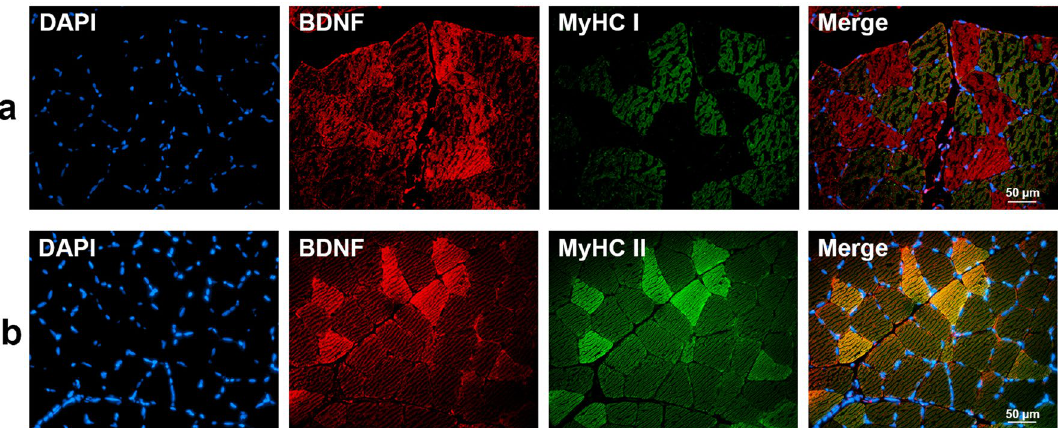
Figure 1. Colocalization of BDNF with slow-type (MyHC I, a ) and fast-type fibers (MyHC II, b ) in soleus (SOL) muscle. DAPI (blue) and MyHC I/II (Myosin Heavy chain I/II, green) were used as nuclear and slow I (MyHC I)/fast II (MyHC II) myosin isoform markers, respectively. Red-labelled immunofluorescence represents BDNF. A great BDNF staining in fast-type fibers was visualized in SOL muscle. Similar results were observed in all examinations ( n = 4). Scale bar 50 µm.